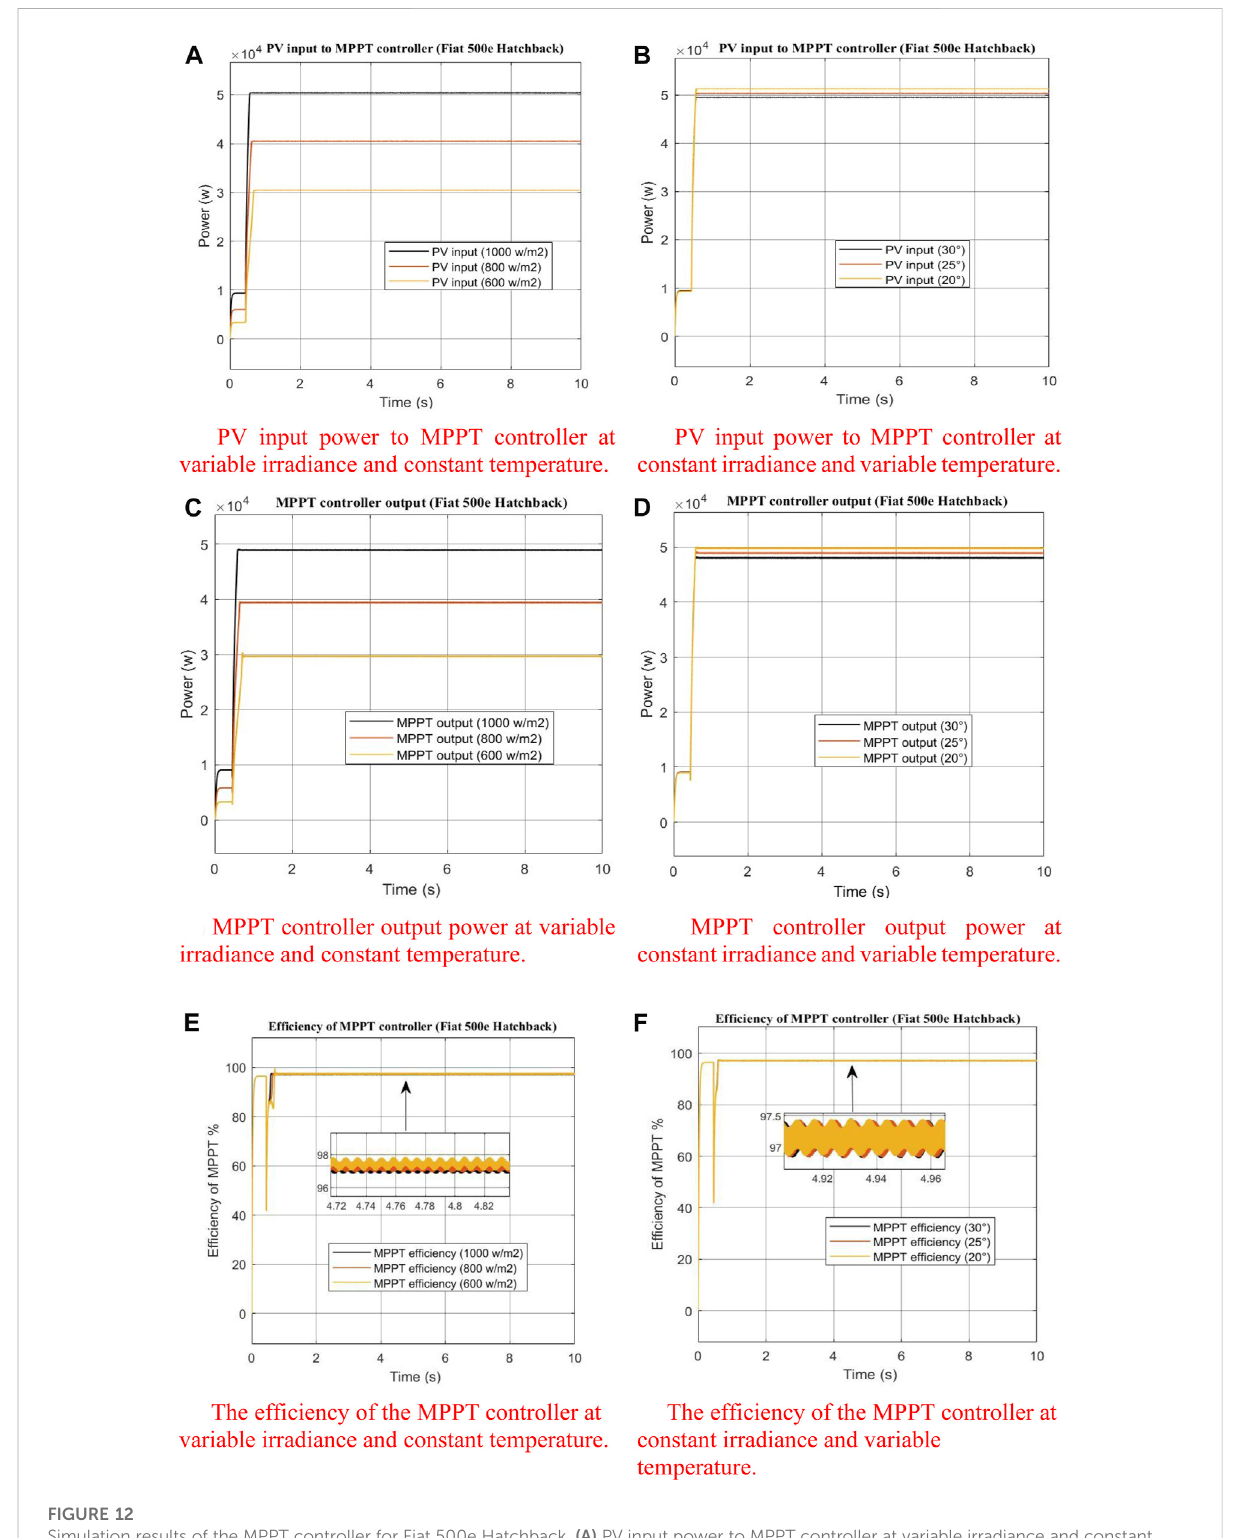
FIGURE 12 Simulation results of the MPPT controller for Fiat 500e Hatchback. (A) PV input power to MPPT controller at variable irradiance and constant temperature. (B) PV input power to MPPT controller at constant irradiance and variable temperature. (C) MPPT controller output power at variable irradiance and constant temperature. (D) MPPT controller output power at constant irradiance and variable temperature. (E) Ef fi ciency of the MPPT controlleratvariableirradianceandconstanttemperature. (F) Ef fi